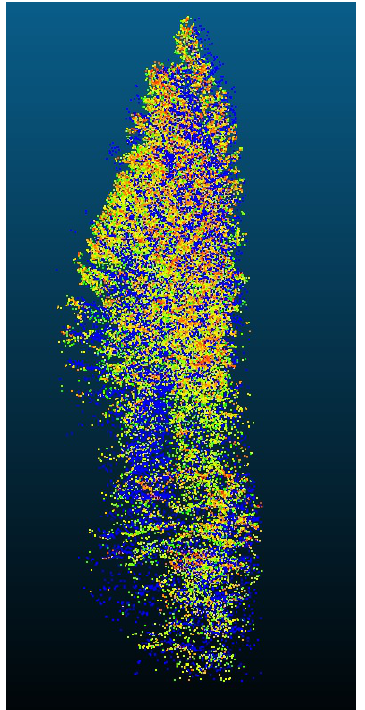
Figure 1. Visualization of an example tree cluster with MLS data. The combined 3D point clouds in the current scene are representing all three spectral channels. Red stands for channel 1, green as channel 2 and blue for channel 3.